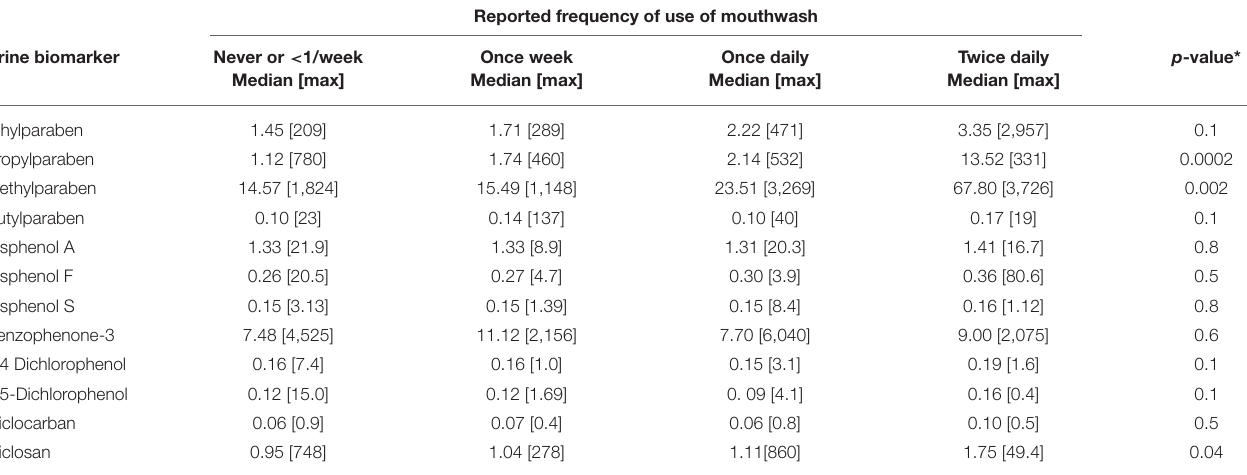
TABLE 2 | Specific-gravity-adjusted urine chemical concentrations (ng/ml) by reported frequency of use of mouthwash for n = 464 participants with information available on reported frequency of use of mouthwash and available urine biomarker concentrations. Reported frequency of use of